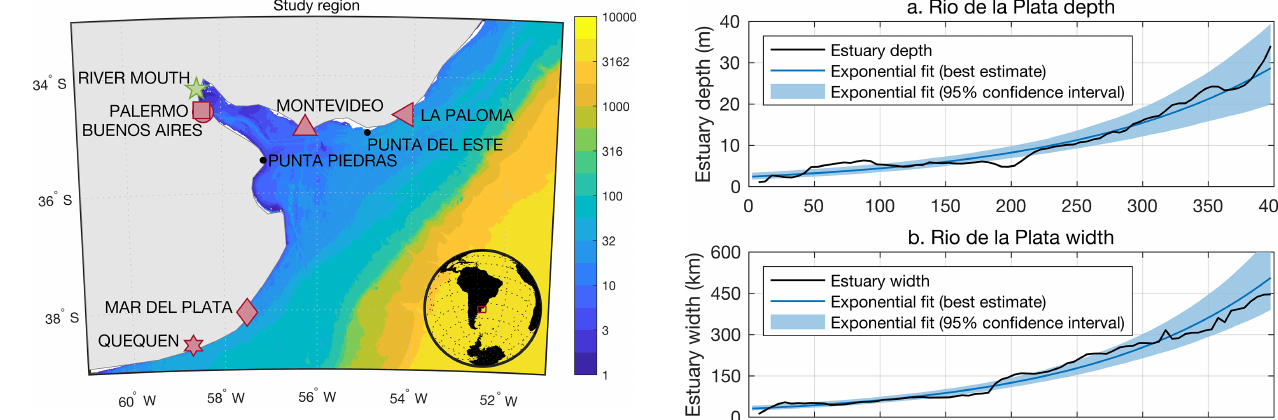
Figure 1. Study region. Color shading is bathymetry (m) from the GEBCO 2021 grid (GEBCO Compilation Group, 2021). Note the nonlinear color scale. Red symbols locate tide gauges. The green star is the river mouth, selected as the confluence of the Río Paraná and Río Uruguay near Isla Oyarvide. Black dots identify other lo- cations referenced in the text. The inset shows the study area in a global context.